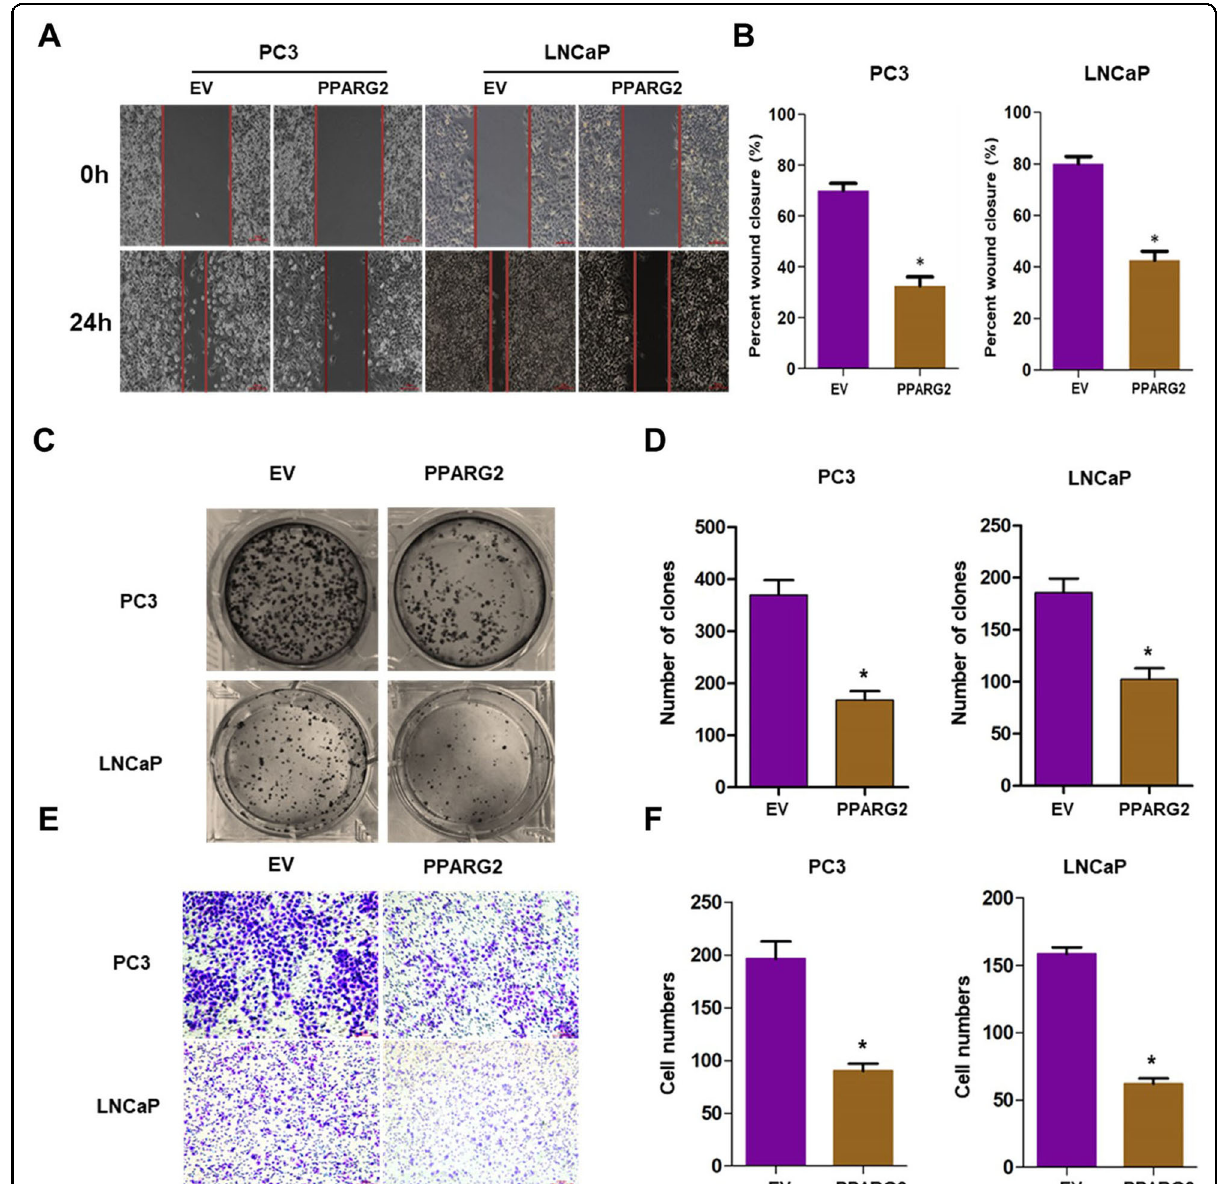
Fig. 2 PPARG2 suppresses cell migration, colony formation, and invasion in vitro. A , B Wound-healing assays were performed to detected the effects of PPARG2 on the proliferation of the PCA cells. * P < 0.05 vs. EV group. C , D Colony formation assays were performed in EV and PPARG2- transfected PCA cells. * P < 0.05 vs. EV group. E , F Representative images of invasion PCA cells transfected with EV or PPARG2 overexpression lentivirus vectors by Transwell cell invasion